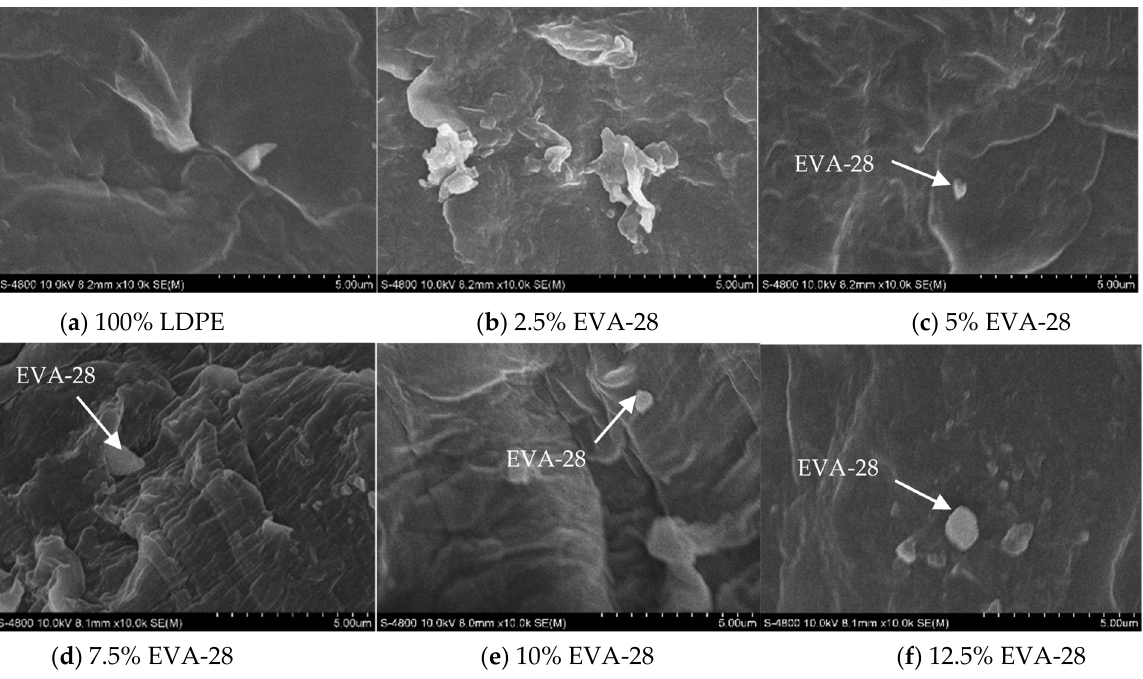
Figure 5. SEM microstructure of the LDPE/EVA mixtures.